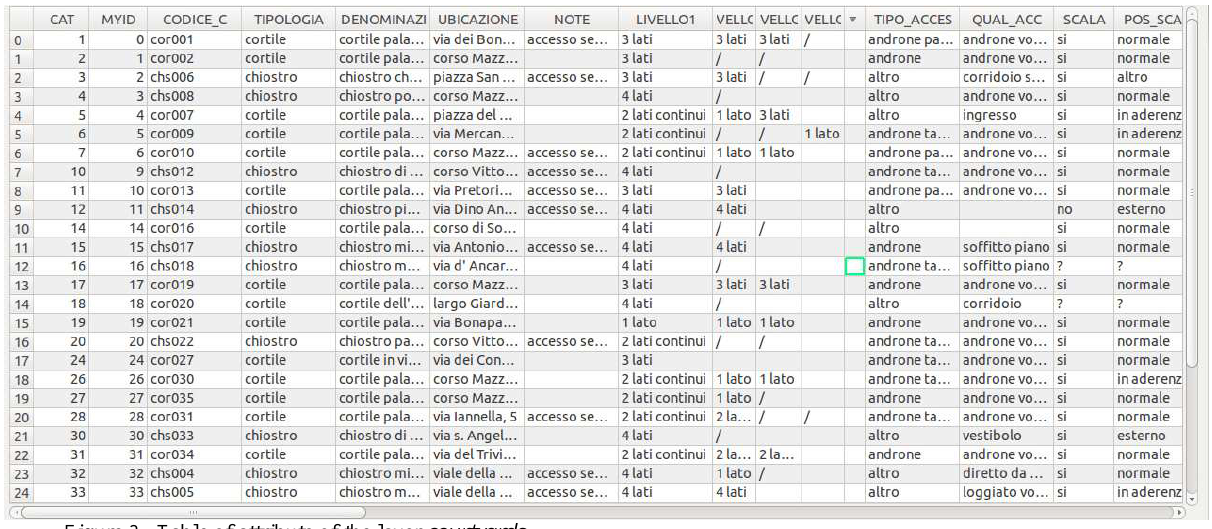
Figure 3. Table of attribute of the layer courtyards